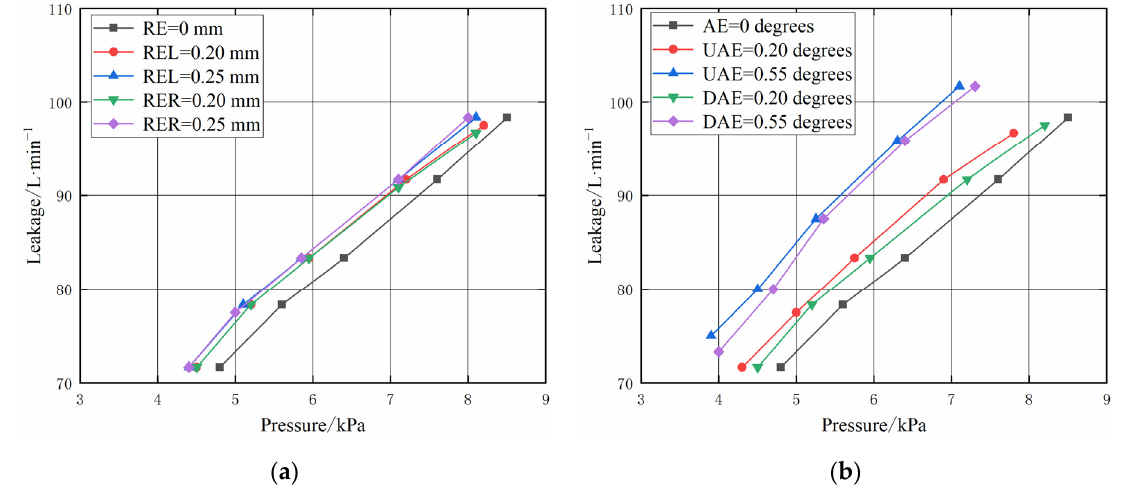
Figure 17. Leakage of honeycomb seal under different eccentricities. ( a ) Radial eccentricity; ( b ) angular eccentricity.